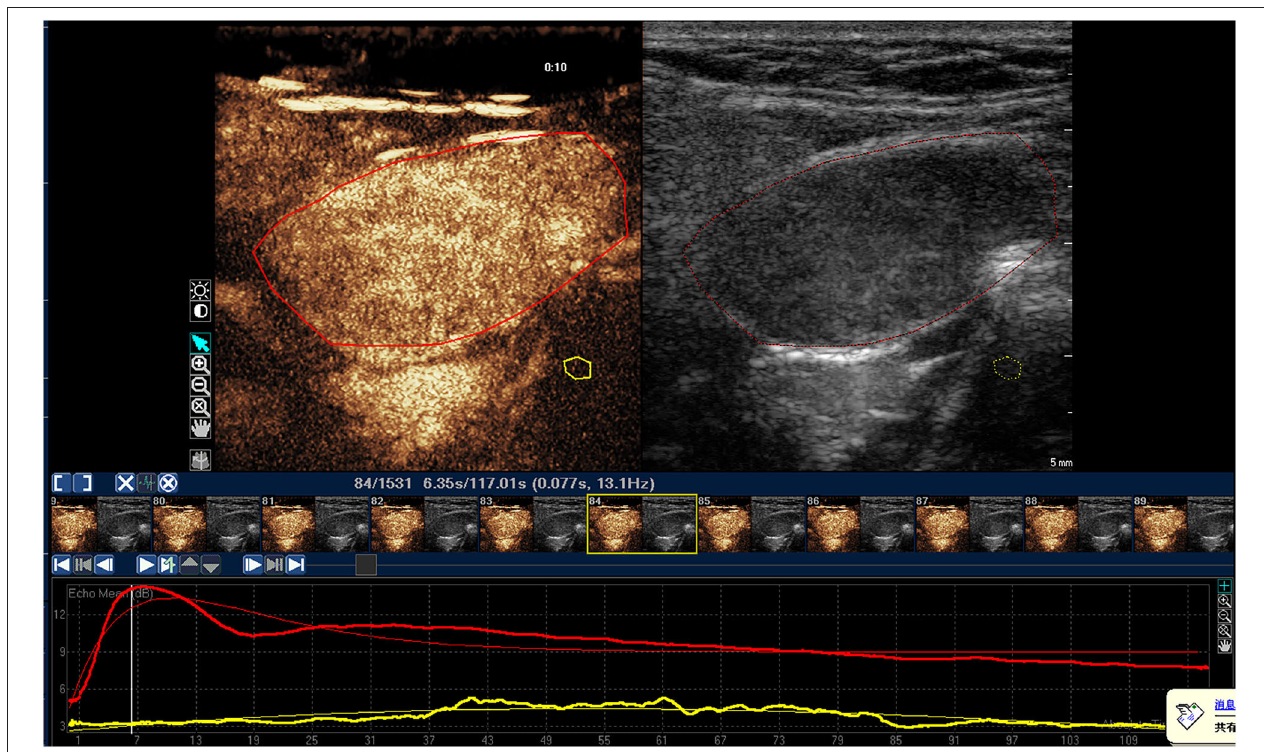
FIGURE 2 | Time-intensity curve of a typical malignant lymph node in NPC patient. The red ROI is malignant lymph node, and the red line is corresponding TIC curve. The yellow ROI is the tissue around the lesion, and the yellow line is the corresponding TIC curve. The malignant lymph node was presented as inhomogeneous enhancement, and PI, TP, and AUC of malignant lymph node were significantly higher than those in benign lymph